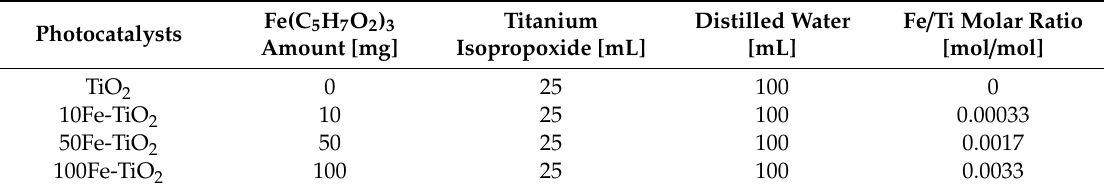
Table 2. List of the prepared photocatalysts, amount of chemicals used in the synthesis, and Fe / Ti molar